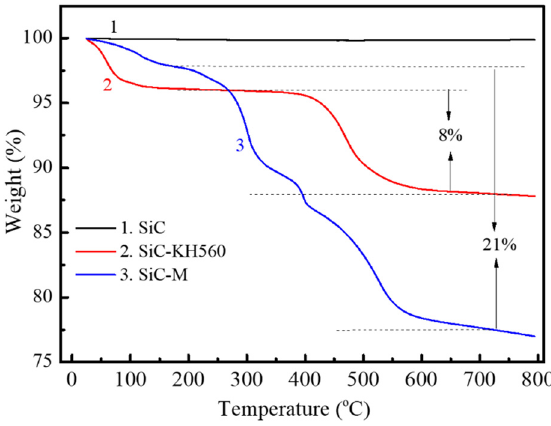
Figure 2: TGA curves of SiC, SiC - KH - 560, and SiC